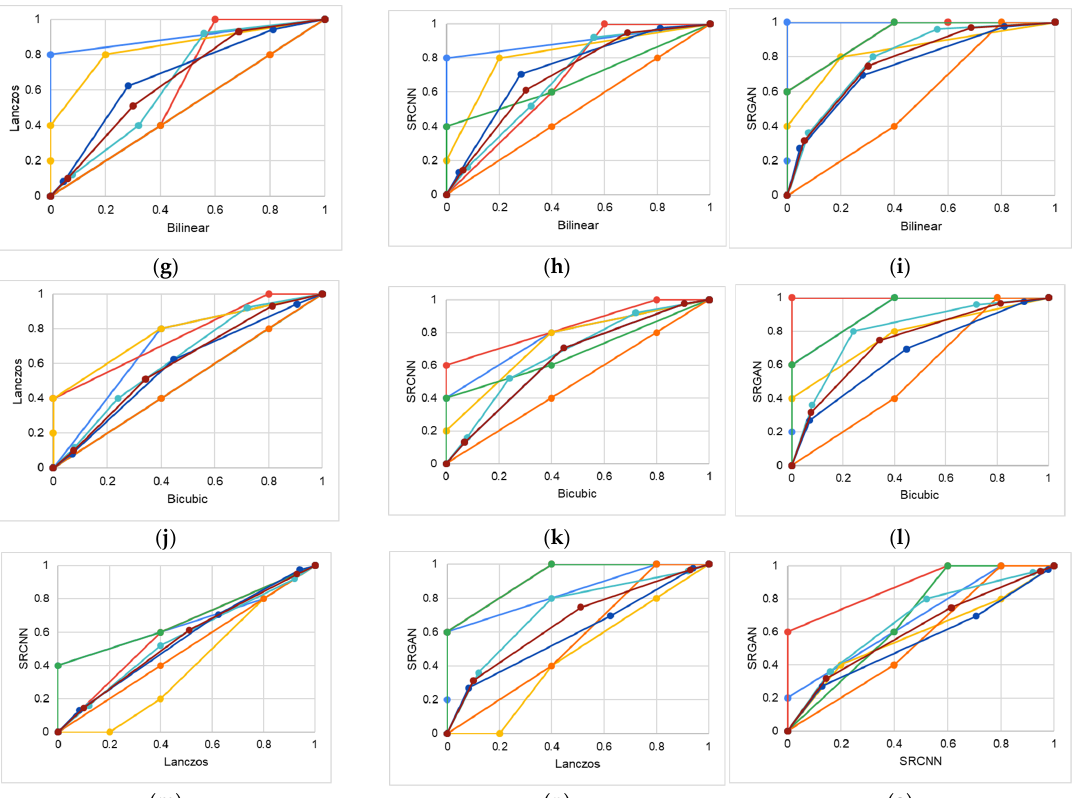
Figure 5. VGC curves obtained for each M A –M B pair: ( a ) nearest–bilinear, ( b ) nearest–bicubic, ( c ) nearest–Lanczos, ( d ) nearest–SRCNN, ( e ) nearest–SRGAN, ( f ) bilinear–bicubic, ( g ) bilinear–Lanczos, ( h ) bilinear–SRCNN, ( i ) bilinear–SRGAN, ( j ) bicubic–Lanczos, ( k ) bicubic–SRCNN, ( l ) bicubic–SRGAN, ( m ) Lanczos–SRCNN, ( n ) Lanczos–SRGAN, and ( o ) SRCNN– SRGAN. General VGC curves in brown, VGC curves for all experts in light blue, curves for lay participants in dark blue, expert 1 in medium blue, expert 2 in red, expert 3 in yellow, expert 4 in green, and expert 5 in orange.